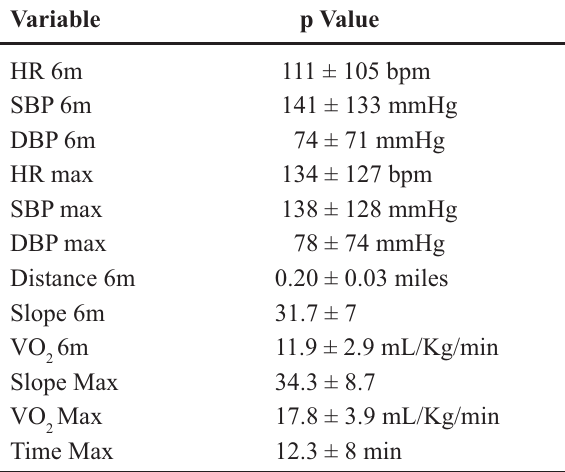
Table 3 – Hemodynamic and exercise